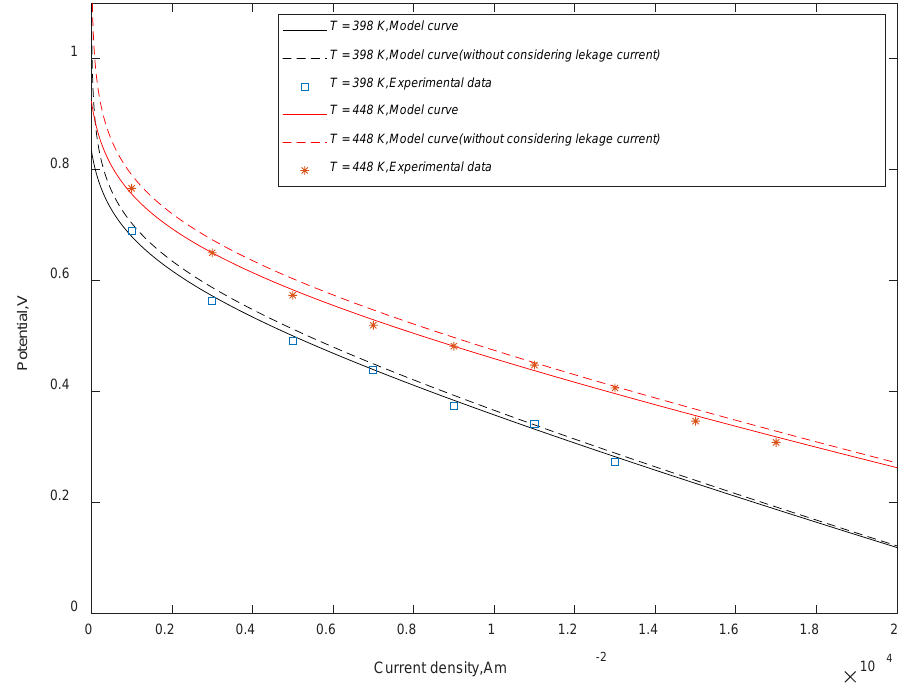
Figure 2. Comparison of model curve and experimental data.